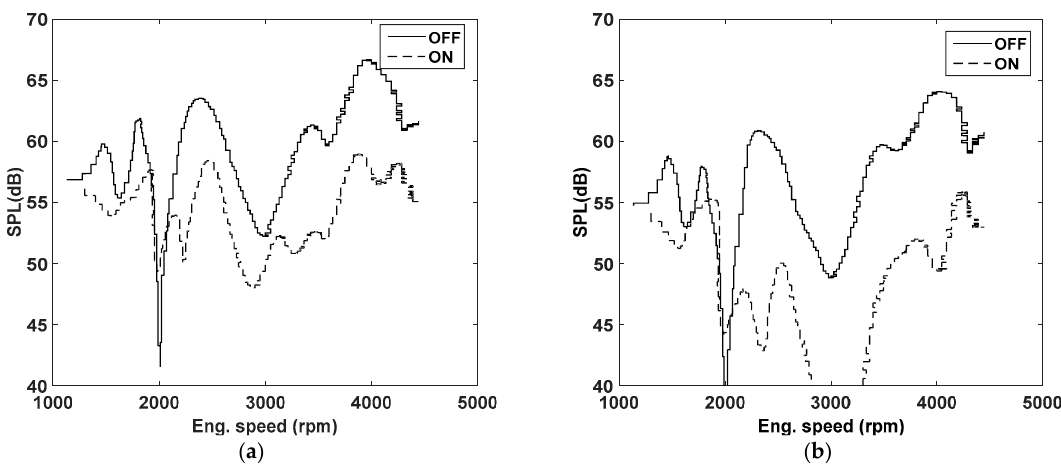
Figure 17. Performance of the ANC system with the new algorithm. ( a ) Overall level; ( b ) Second order. The driving condition is the road condition. (Solid line: ANC off. Dotted line: ANC on.).